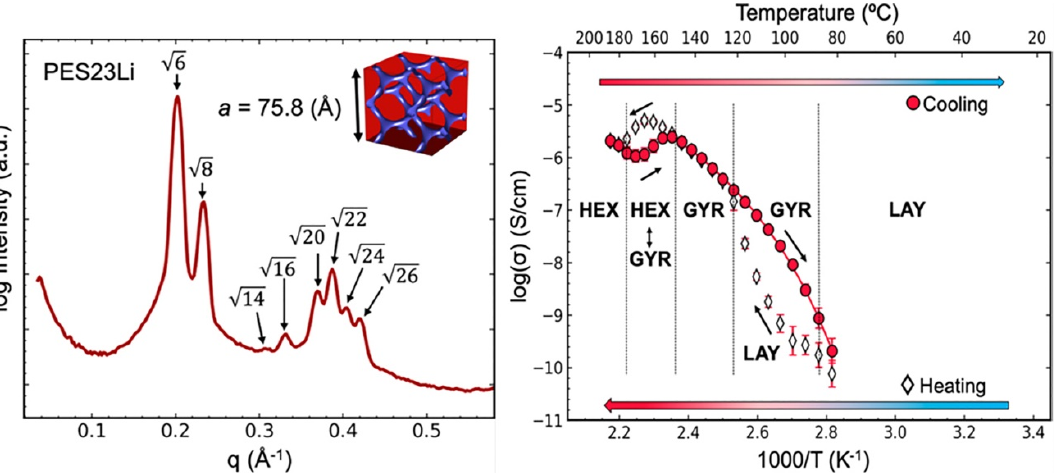
Figure 4. ( a ) Formation of ionic channels induced by interaction of polar groups that favors the proton exchange capacity in fuel cells. ( b ) Different morphologies adopted by the relation of ionic liquids and sulfonic acid groups and its corresponding ionic conductivity. Adapted with permission from reference [76]. Copyright 2021, American Chemical Society.